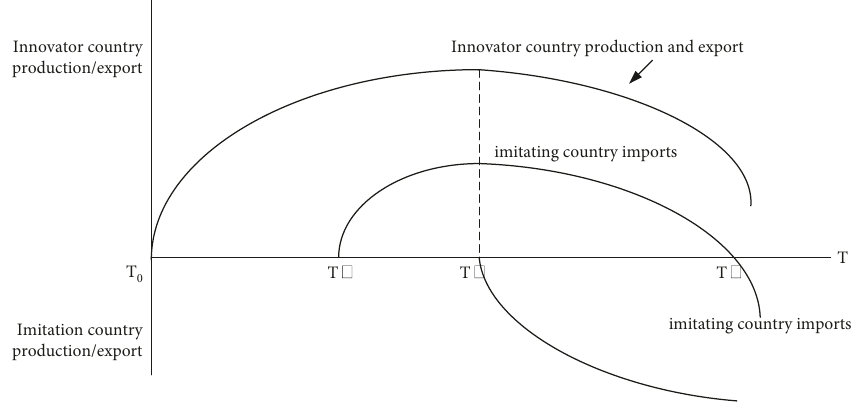
Figure 4: The role of technology gaps.